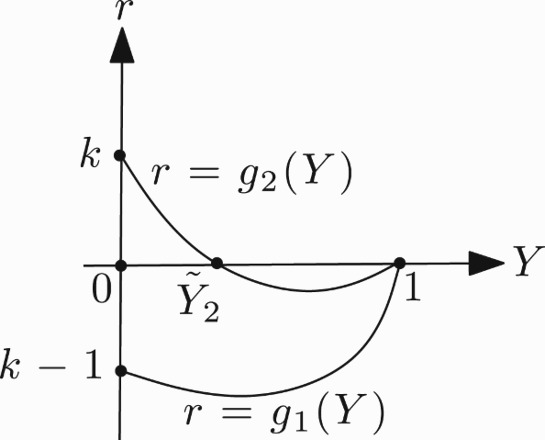
Graph of the functions g
1 and g
2 in the case 0<k≤1.